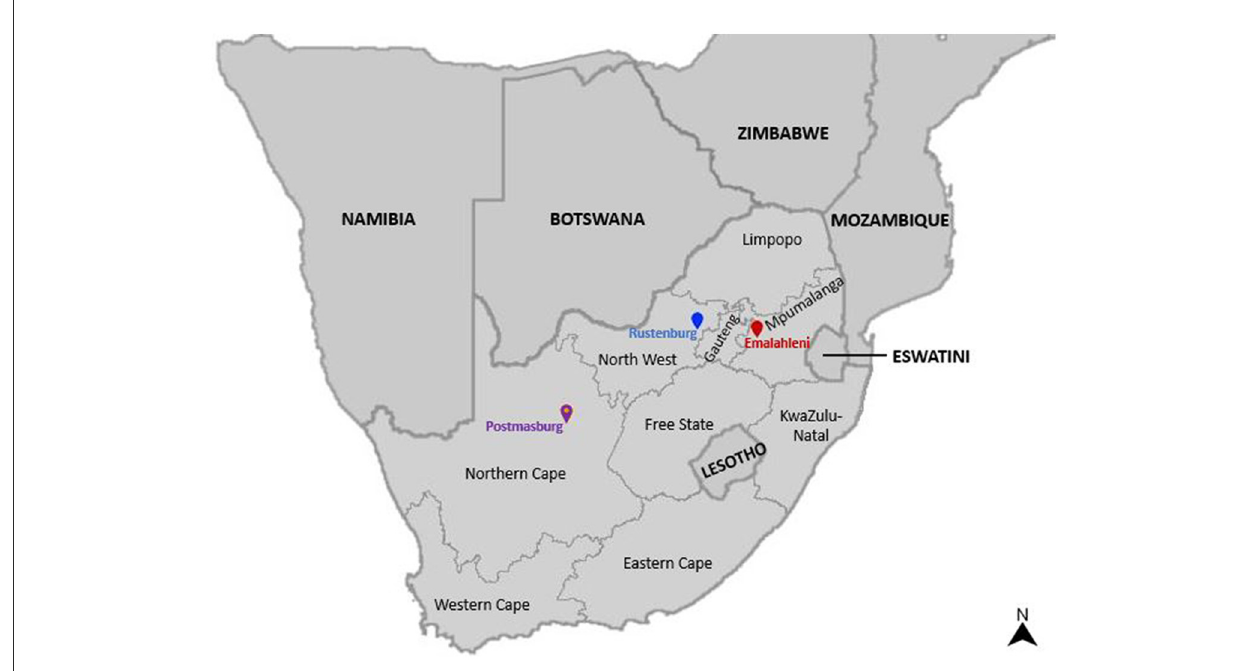
FIGURE1 Location of the three mining communities in South